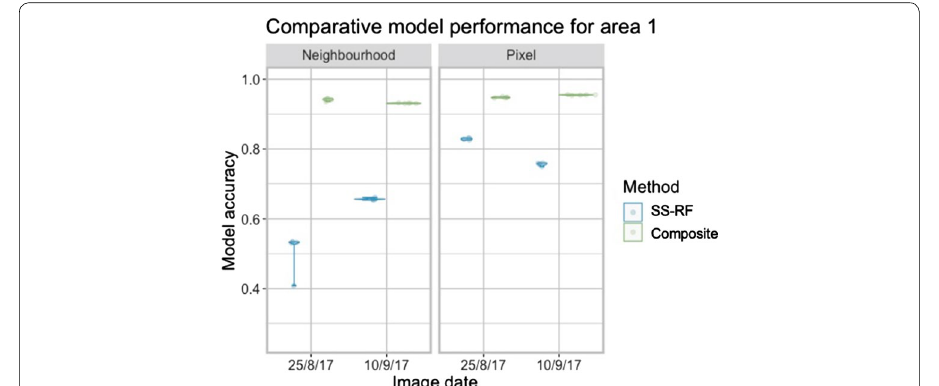
Fig. 11 Comparative accuracy of the SS‑RF and compositing approaches interpolating forest and not forest land cover classifications for area 1. SS‑RF results are shown by the blue violin plots and composite results are shown by the green violin plots